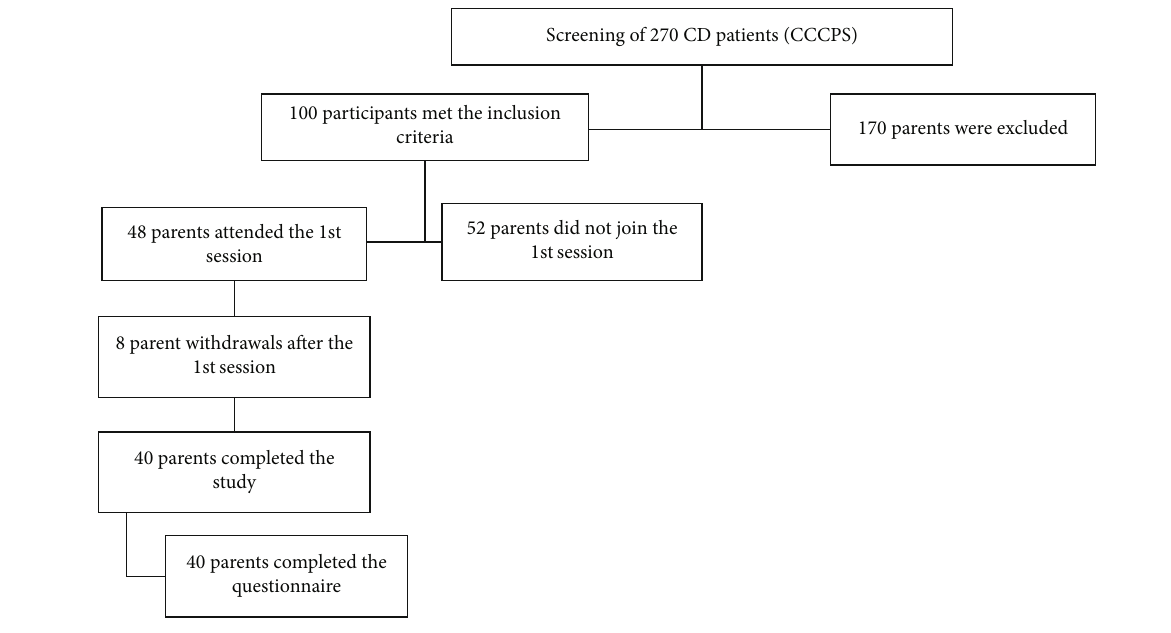
Figure 2: Flow diagram of CD parent participation. Table 1: Sociodemographic characteristics of CD patients and their